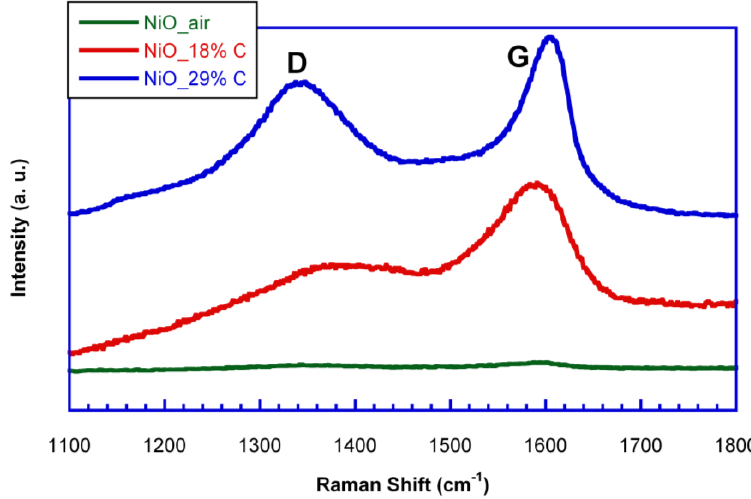
Figure 3. Raman spectra of NiO_air, NiO_18%C and NiO_29%C samples.